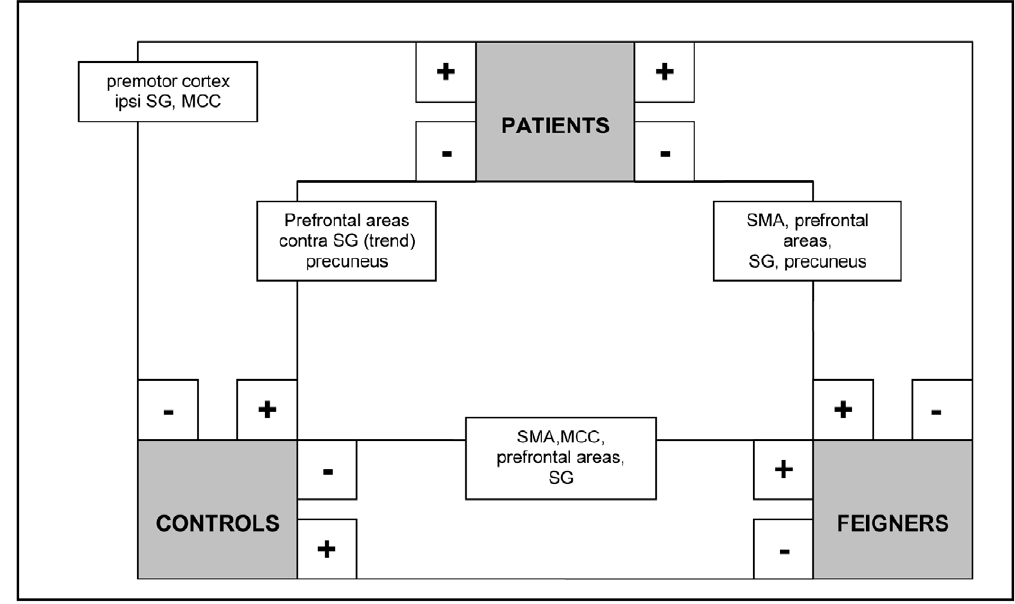
Figure 2. Schematic summary of significant clusters (P , 0.05, whole-brain corrected at cluster level; k . 200) in between-group comparisons (flipped data): movement execution in the affected hand (analysis C). + =significantly more activated than -.